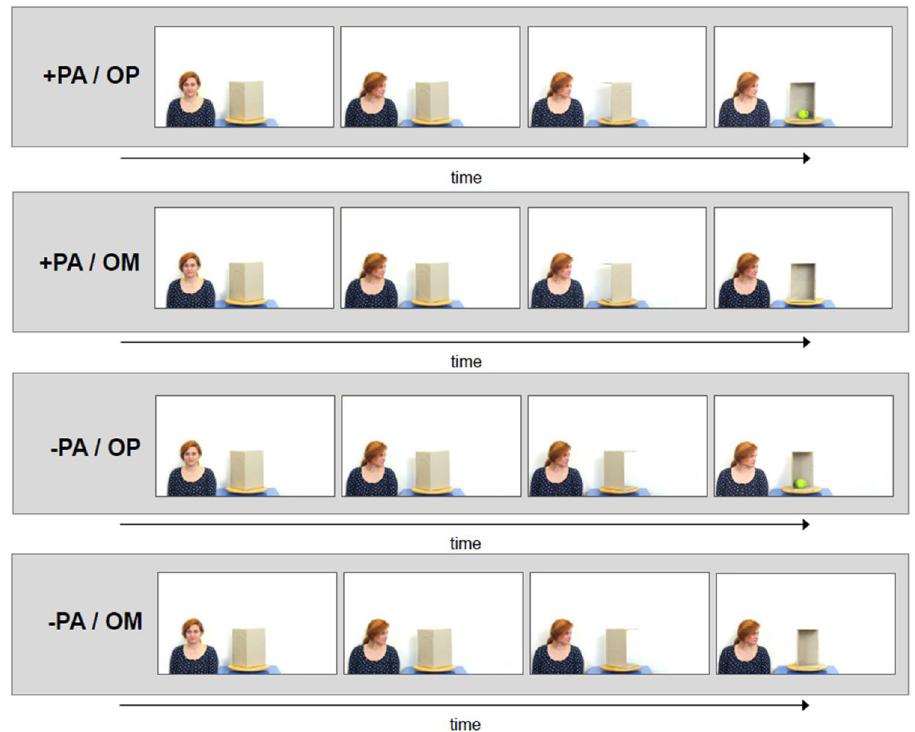
Figure 1. The experimental conditions of the study. In the ambiguous content in the perceived access (+ PA) condition, the box rotates toward the agent, while in the perceived non-access (−PA) condition the box rotates the other way around. At the end of the events, either an object was present (OP) or not (OM). Person in the stimulus has signed an informed consent form of publication of identifying images in an open-access